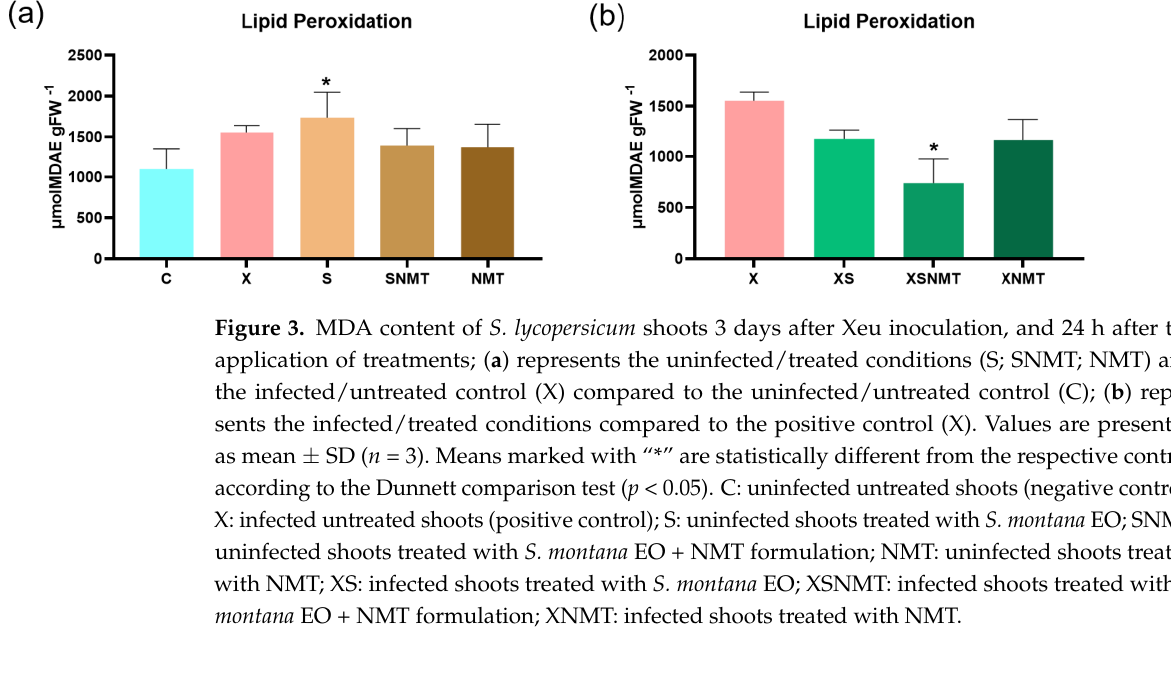
Figure 2. H 2 O 2 and O 2.- content of tomato shoots 3 days after infection and 24 h after the application of treatments. ( a , c ) stand for the levels of the uninfected/treated groups (S; SNMT; NMT) and the infected control (X) compared to the negative (C) control; ( b , d ) represent the levels on in- fected/treated groups (XS; XSNMT; XNMT) compared to the infected control (X). All values are pre- sented as mean ± SD ( n = 3). Means marked with an asterisk are statistically different from the re- spective control according to the Dunnett comparison ( p < 0.05). C: uninfected untreated shoots (control); X: infected untreated shoots; S: uninfected shoots treated with S. montana EO; SNMT: un- infected shoots treated with S. montana EO + NMT formulation; NMT: uninfected shoots treated with NMT; XS: infected shoots treated with S. montana EO; XSNMT: infected shoots treated with S. montana EO + NMT formulation; XNMT: infected shoots treated with NMT.